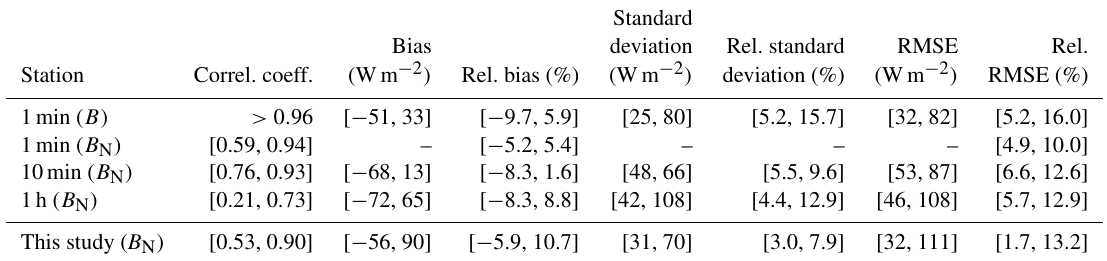
Table 19. Ranges of correlation coefficients, bias, standard deviations, RMSE, and their values relative to the mean of the measurements for B or B N for summarizations 1min, 10min, and 1h, as well as those of the present study. Standard Bias deviation Rel. standard RMSE Rel. Station Correl.